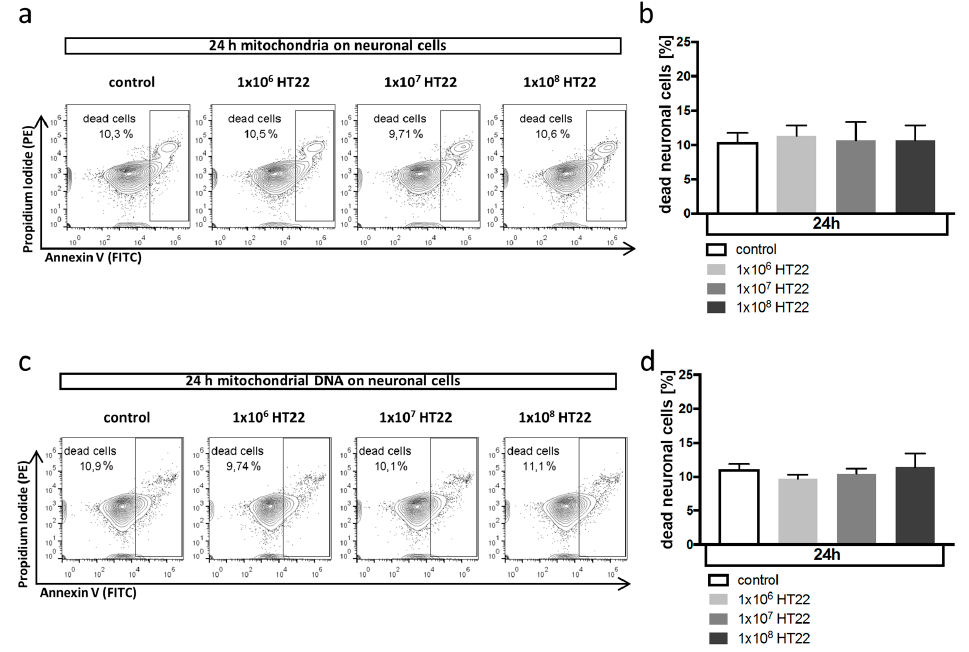
Figure 2. Mitochondrial DAMP pathway does not affect neuronal cell death. a , b: Effect of mitochondria isolated from HT22 cells on neuronal cell death in HT22 cells in vitro analyzed by